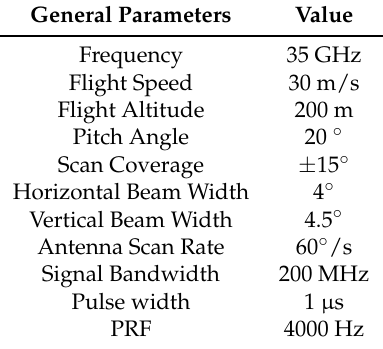
Table 4. Experimental parameters.